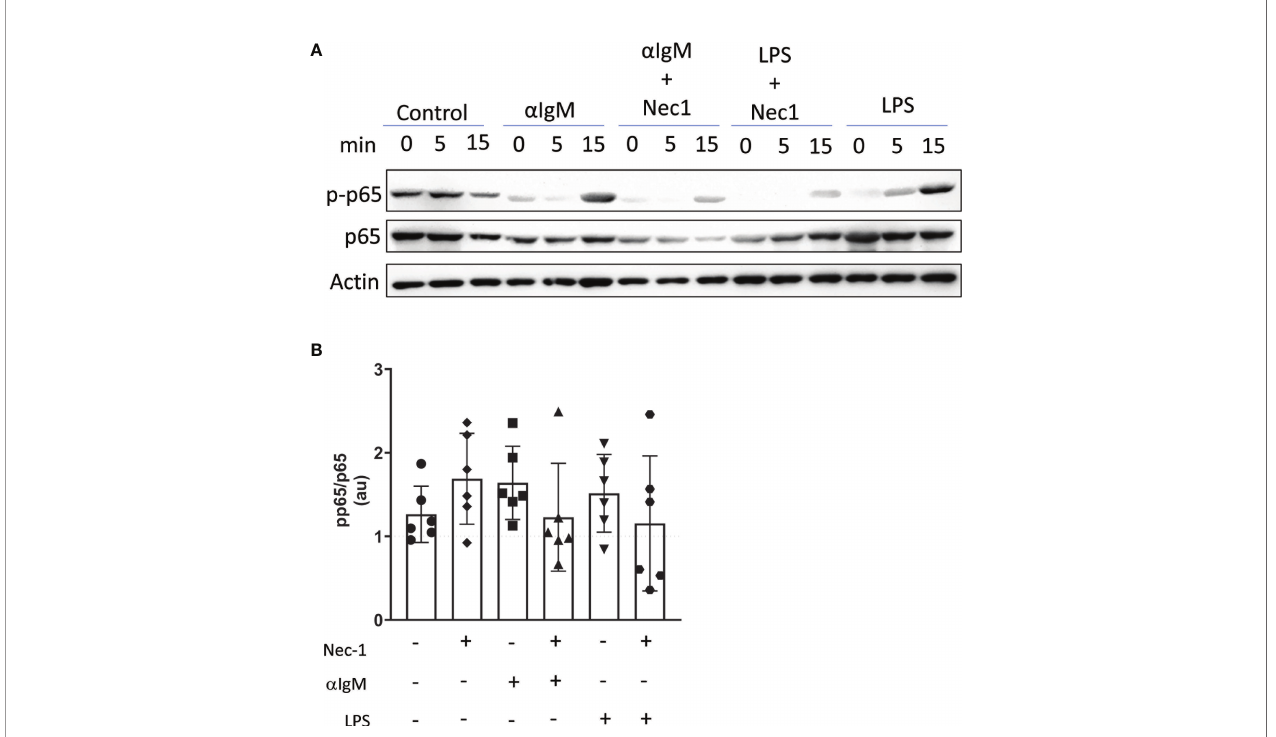
FIGURE 7 | RIP1 inhibitor Necrostatin-1 reduces BcR mediated induction of p-p65. Immunoblot detected p-p65, p65, and b -actin protein in lysates from WT splenic B cells pretreated in vitro with or without 39.5 mM necrostatin-1 (Nec1) for 60 min and then stimulated with 15 mg/ml anti-Ig F(ab ’ ) 2 or 10 mg/ml LPS for 0, 5, 15 min (A) . Band intensity at 15min timepoint was quanti fi ed with Image J and is expressed as a ratio of pp65 to p65 arbitrary units (au) each normalized to actin (B) . Data is representative (A) or a pool (B) of six independent experiments, each with splenocytes from a single mouse. Each symbol identi fi es an individual mouse/experiment. (One way ANOVA, Friedman